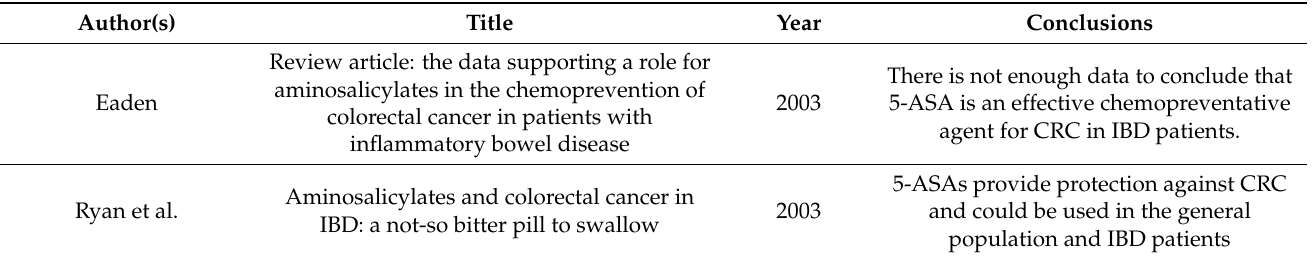
Table 1. Summary of